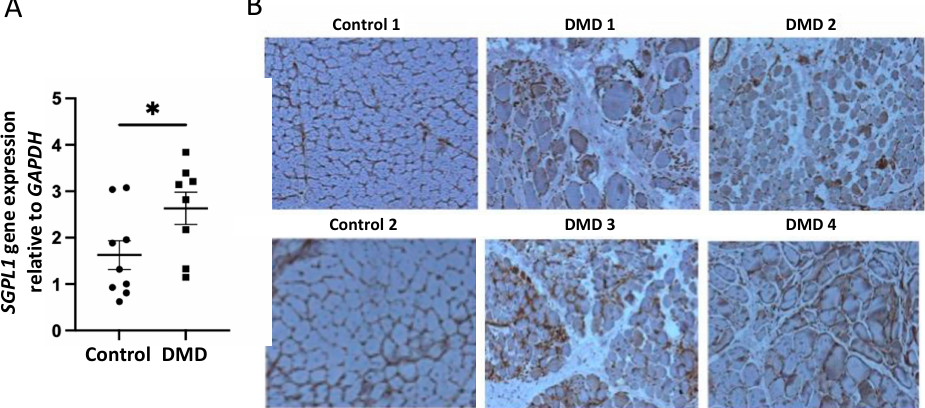
Figure 1. SGPL1 /SPL is upregulated in dystrophic muscles of DMD patients. ( A ) qRT-PCR of SGPL1 human gene expression in DMD skeletal muscle ( n = 8) compared to control muscle ( n = 9). Gene expression is normalized to GAPDH . Mean ± SD; * p < 0.05. ( B ) SPL protein expression as shown by immunohistochemistry (brown signal) in two controls and four DMD patients. Controls and DMD-1, -2 and -3 are from gastrocnemius . DMD-4 is from tibialis anterior .